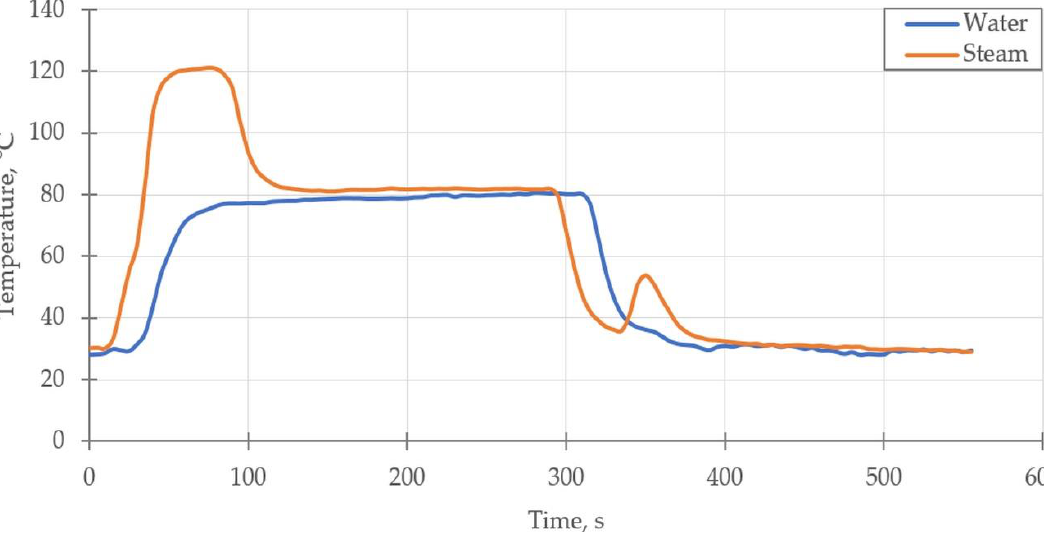
Figure 4. Temperature of the medium outlet (T7) from the adsorption chiller bed during desorption.